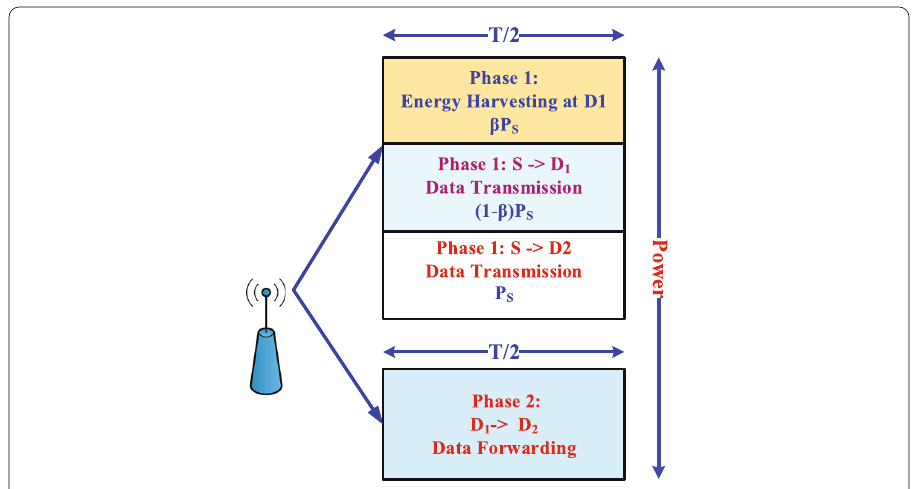
Fig. 2 Energy harvesting and data transmission